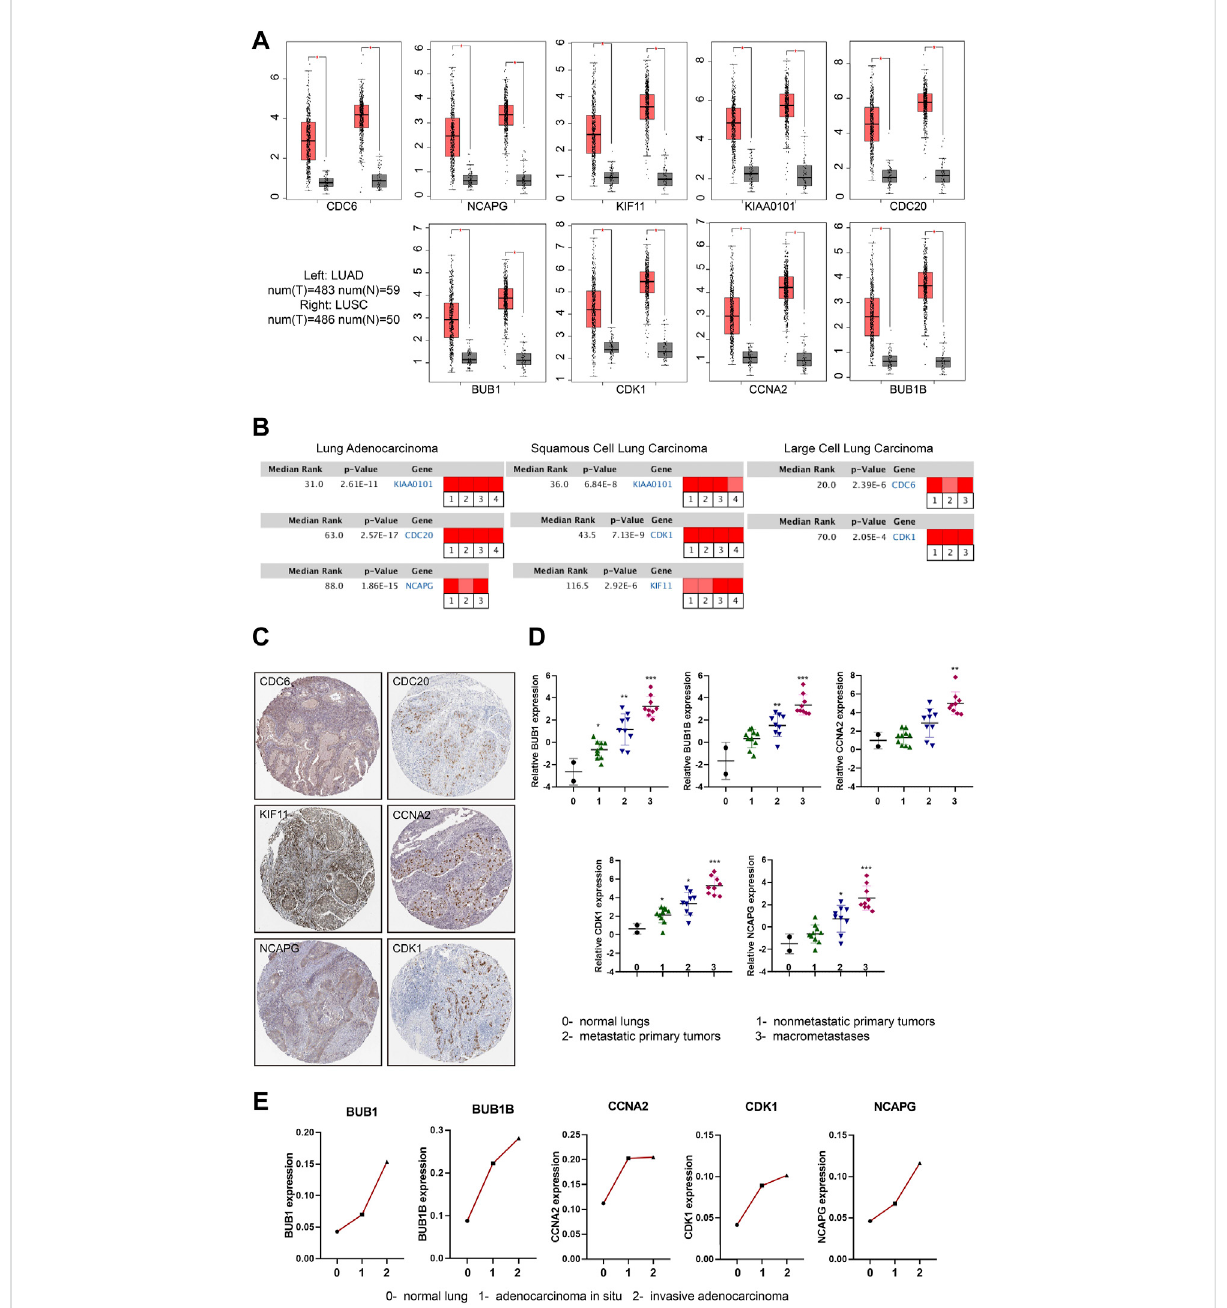
FIGURE 3 mRNA and protein expression changes of hub genes in NSCLC. (A) Boxplots (Red box: tumor tissue; Grey box: normal tissue) showing the expression levels of hub genes based on the TCGA database. The red and grey boxes represent NSCLC and normal tissues, respectively. |Log 2 FC| cutoff = 1, p value cutoff = 0.05. (B) Rank of hub genes changes in subtypes of NSCLC according to Oncomine database (Red represents up- regulated). |Log 2 FC| cutoff = 1, p value cutoff = 0.001. (C) Immunohistochemical staining of hub genes in NSCLC tumor cells included in HPA database. (D) The expression of hub genes with the progression of LUAD in GSE84447 dataset: 0- normal lungs ( n = 2), one- nonmetastatic primary tumors( n =10),two-metastaticprimarytumors( n =9),3-macrometastases( n =9). (E) TheexpressionofhubgeneswiththeprogressionofLUADin GSE52248 dataset. Each point represents the average value of the group (each group: n = 6). * p < 0.05, ** p < 0.01, *** p < 0.001, **** p <